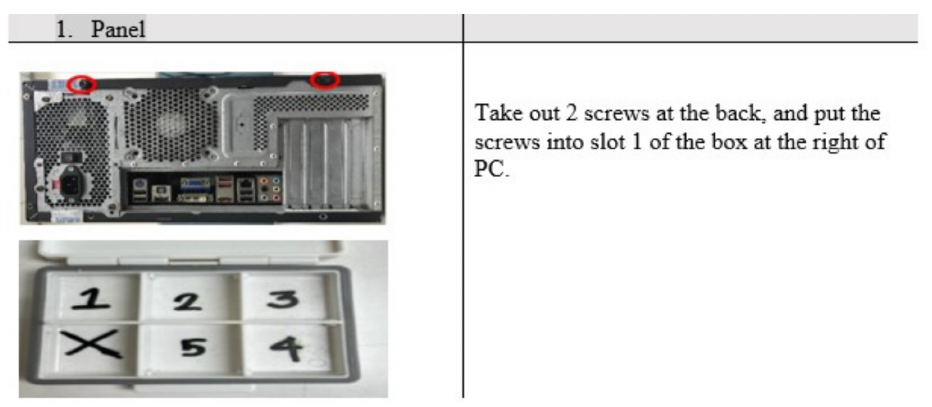
Figure 4. Step 1 of disassembly task in the printed